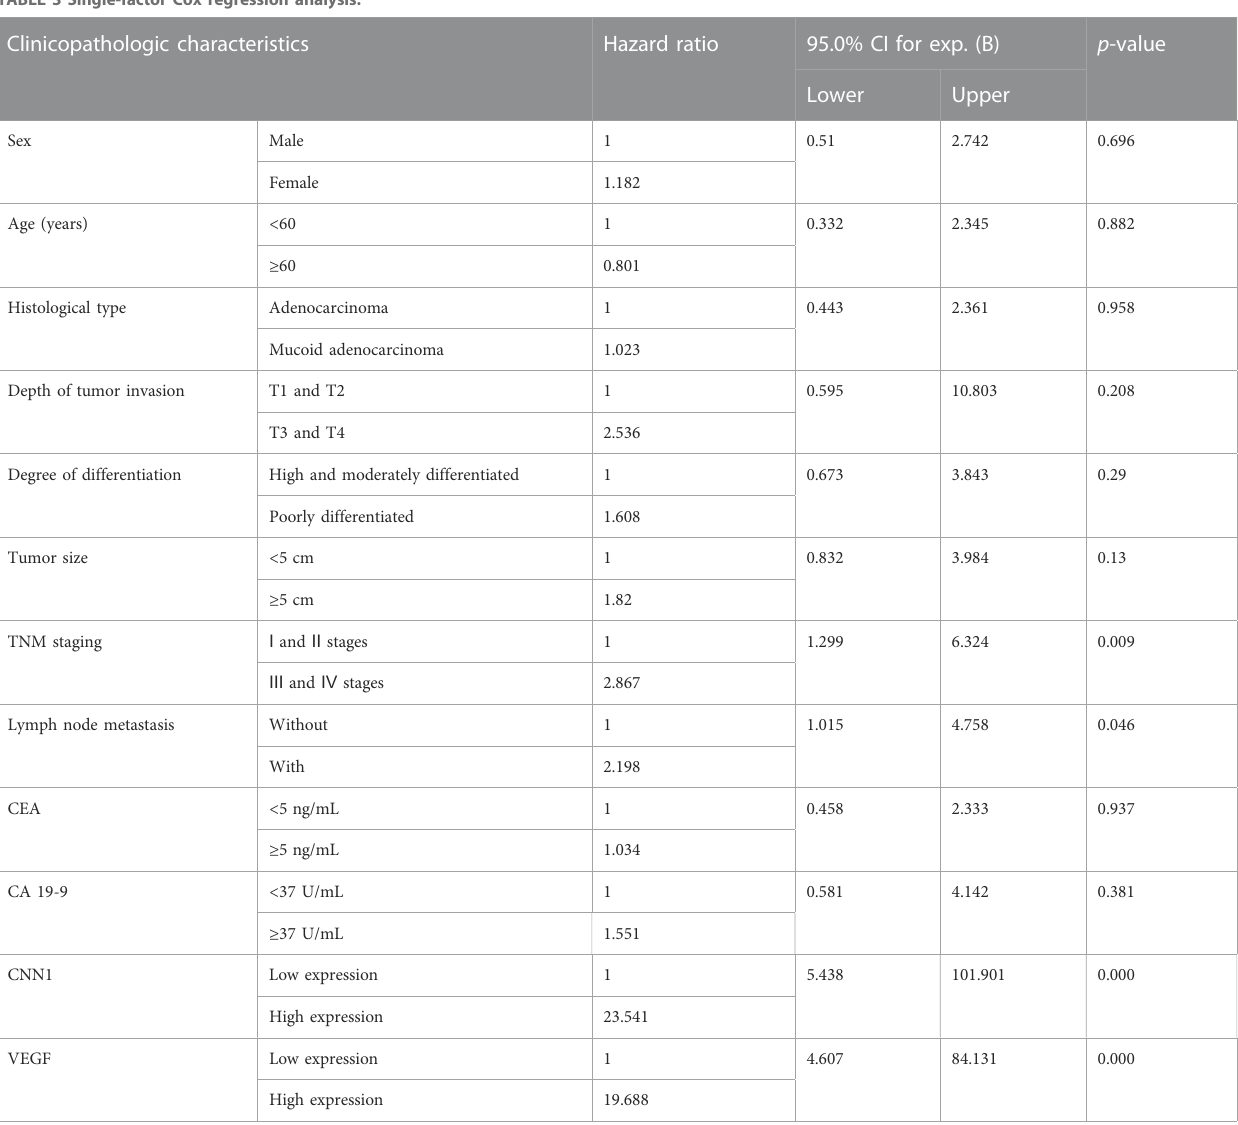
TABLE 3 Single-factor Cox regression analysis. Clinicopathologic characteristics